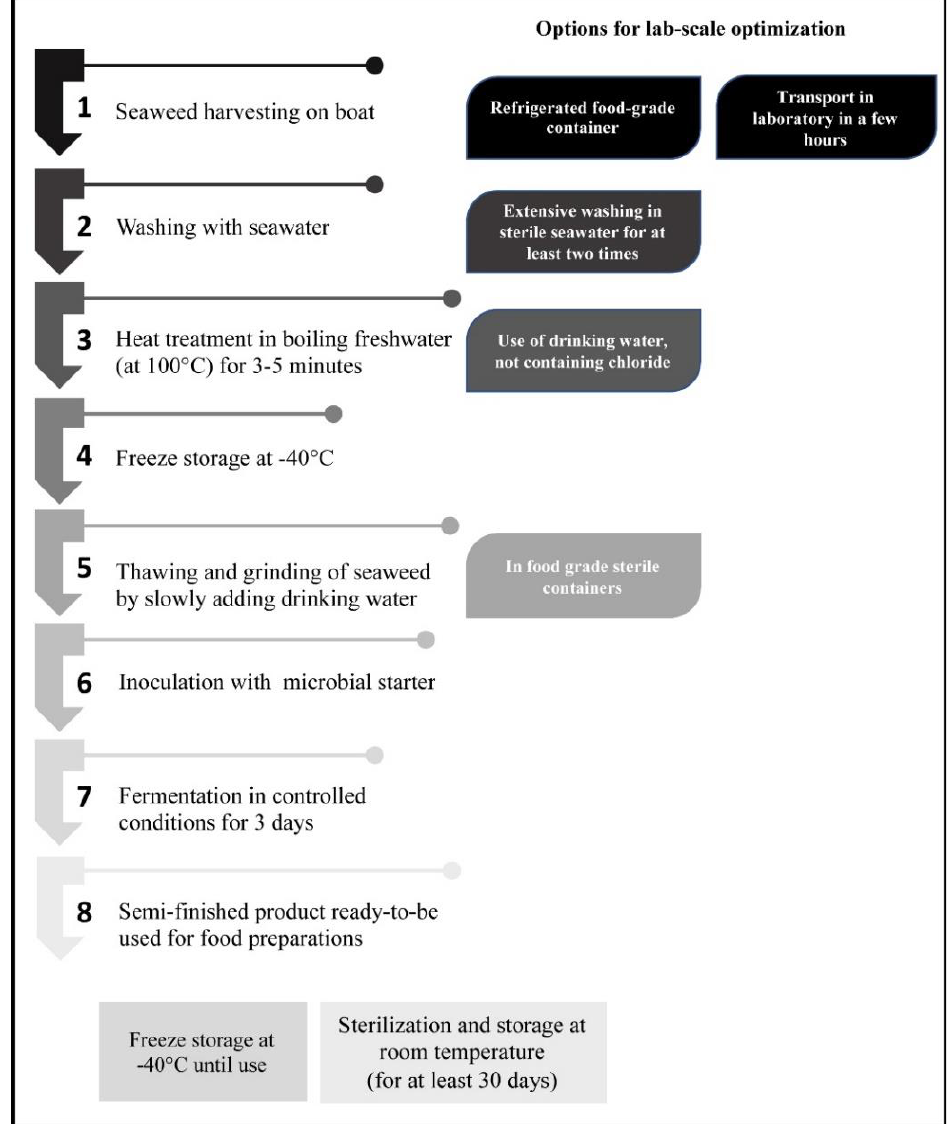
Figure 1. Diagram illustrating the procedure of the new proposed seaweed treatment method. Three different microbial starter fermentation strategies were approached using com- mercially available preparations: Lactobacillus acidophilus (Prodeco Pharma srl, Castelfranco Veneto, Italy); Staphylococcus xylosus (PROMIX 1, Sacco srl, Cadorago, Italy); a mix of Lactobacillus sakei , Staphylococcus carnosus and Staphylococcus xylosus (SBM-11, Sacco srl, Cadorago, Italy). Although seaweeds were tested as ingredients added in media for the LAB strains growth [13,15], at the best of our knowledge, no applications concerning the use of non-conventional starter cultures of coagulase-negative staphylococci for fermenting seaweed have been reported.